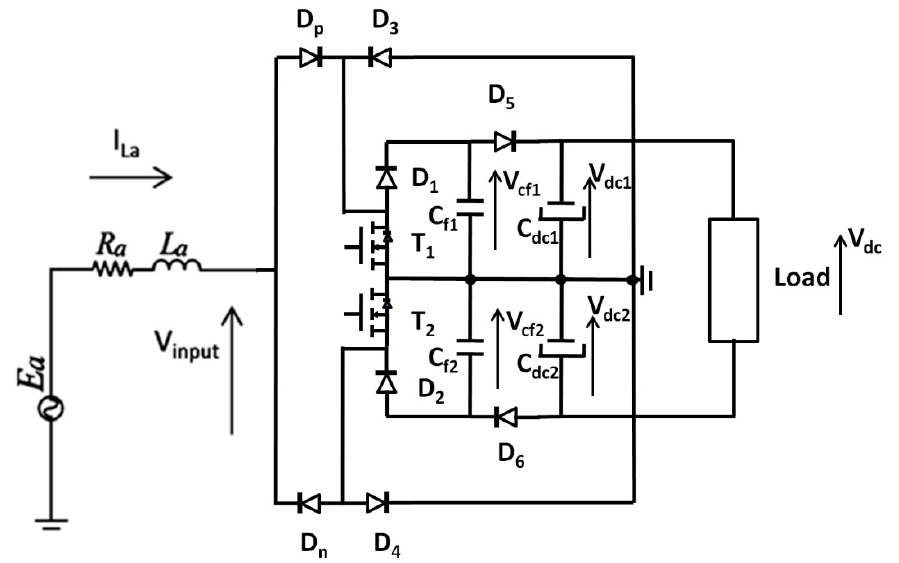
Figure 1. Single-phase five-level VIENNA converter with only two